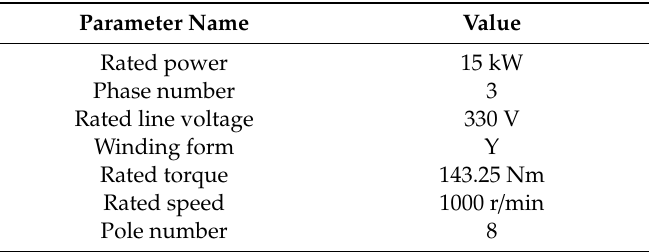
Table 2. Basic parameters of IWM.